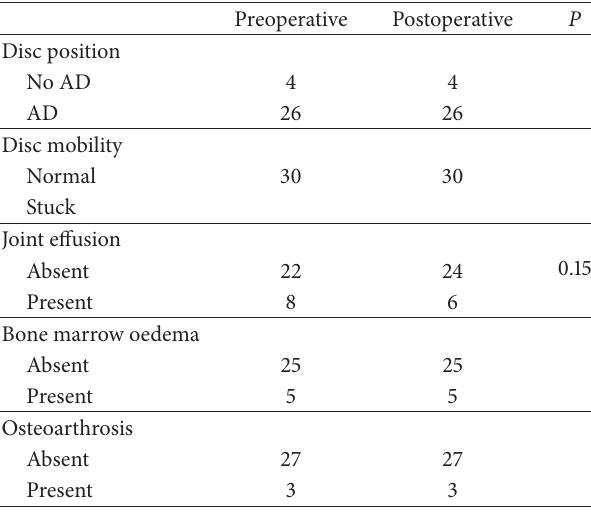
Table 3: Changes in MRI